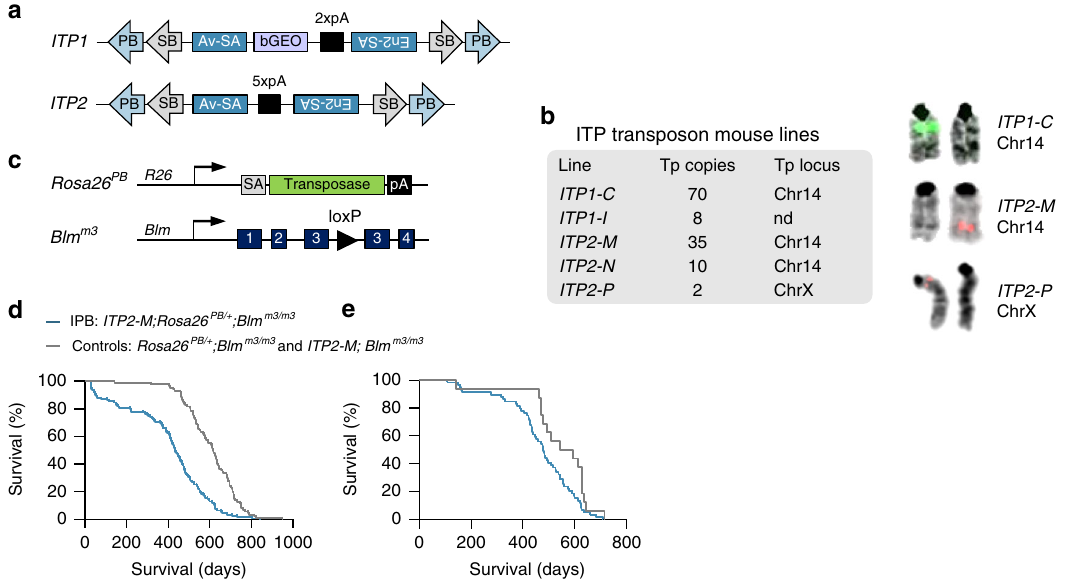
Fig. 1 A PiggyBac transposon system for recessive screening in mice. a Structure of "inactivating transposons" ITP1 and ITP2 . b Transgenic mouse lines generated using ITP1 or ITP2 . Transposon copy numbers within the transgene array as well as the chromosomal donor locus of the array are shown. Chromosomal donor loci for different lines are shown on the right, as detected by fl uorescence in situ hybridization with transposon-speci fi c probes. Note that the ITP2-M and ITP2-N mouse lines emerged from a single founder animal. c Structures of the Rosa26 PB and Blm m3 alleles as described earlier 20,33 . The Rosa26 PB knock-in allele expresses the insect version of the PiggyBac transposase constitutively driven by the endogenous Rosa26 promoter. d , e Kaplan – Meier plots showing survival of IPB and control mice. In d the whole cohort is shown ( n = 123 [IPB], n = 87 [controls]; p < 0.0001, log-rank test). e represents survival curves for mice displaying hematopoietic tumors characterized histopathologically ( n = 59 [IPB], n = 16 [controls]; p = 0.025, log-rank test). PB PiggyBac, SB Sleeping Beauty, Av-SA adenovirus-derived splice acceptor, bGEO β -galactosidase/neomycin resistance reporter including the bovine growth hormone polyadenylation signal, En2-SA Engrailed-2 exon-2 splice acceptor, pA SV40 bidirectional polyadenylation signal, Tp transposon, R26 Rosa26, SA splice acceptor, Blm Bloom syndrome RecQ like helicase, nd not